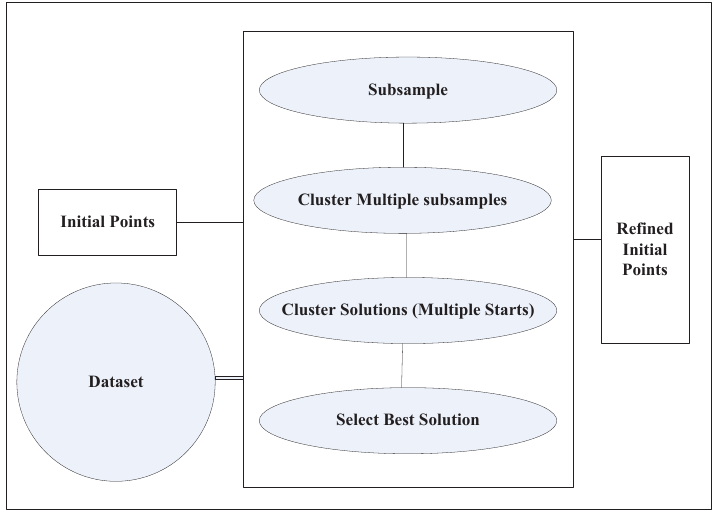
Figure 2. Refined initial instances, adapted from